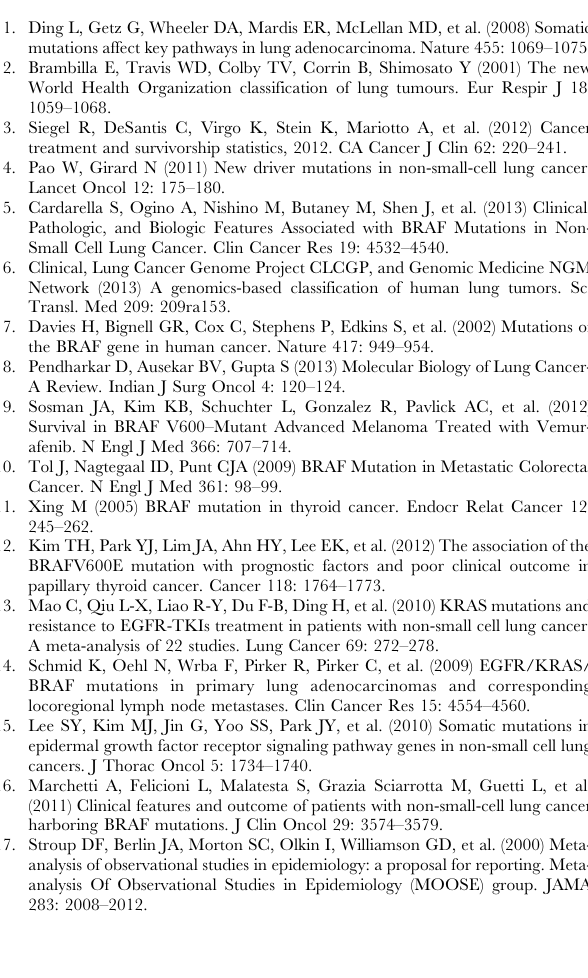
Table S1 Subgroup analysis of the relationship between